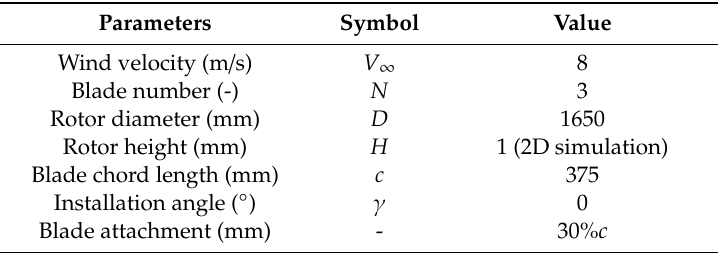
Table 2. Design parameters of VAWT.